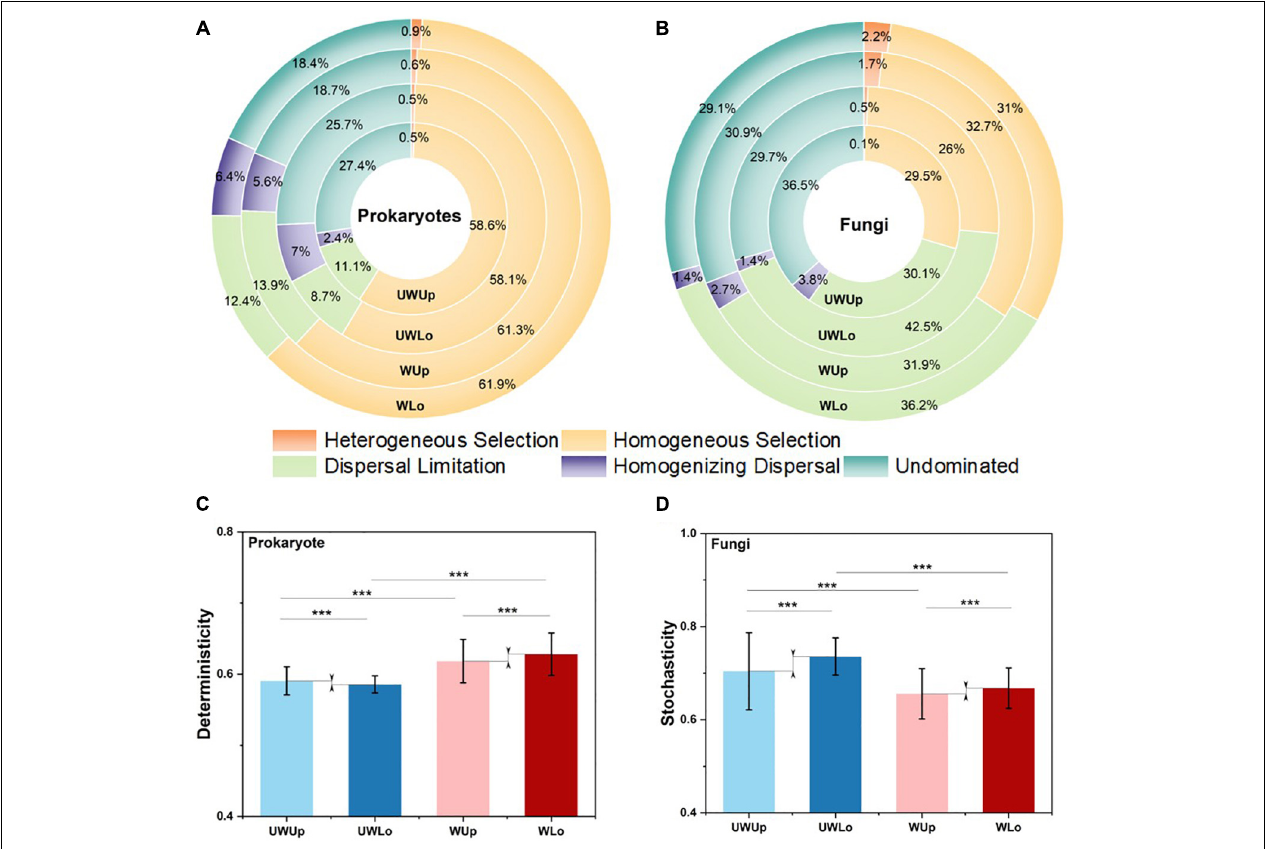
FIGURE 2 | Proportion of ecological processes for prokaryotic (A) and fungal (B) community assembly. Homogeneous selection and dispersal limitation were selected to make comparison between different communities for prokaryotic (C) and fungi (D) , respectively. *** p < 0.001, this significance was measured by unpaired Student’s t test. UWUp, unwarming upper; UWLo, unwarming lower; WUp, warming upper; WLo, warming lower.